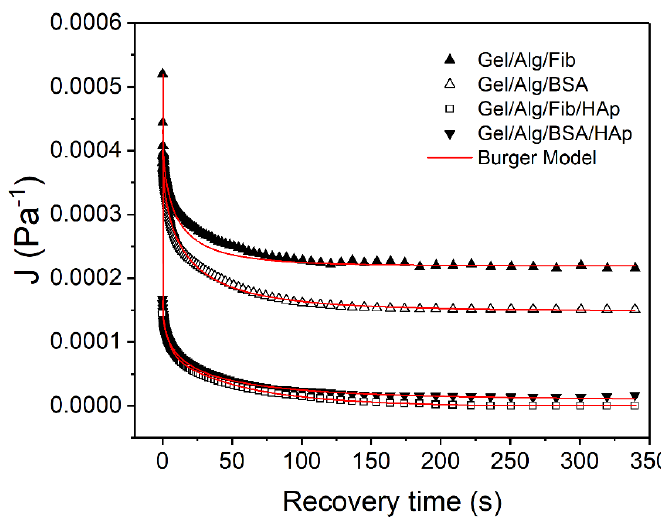
Figure 10. Fitted curves for the creep phase.